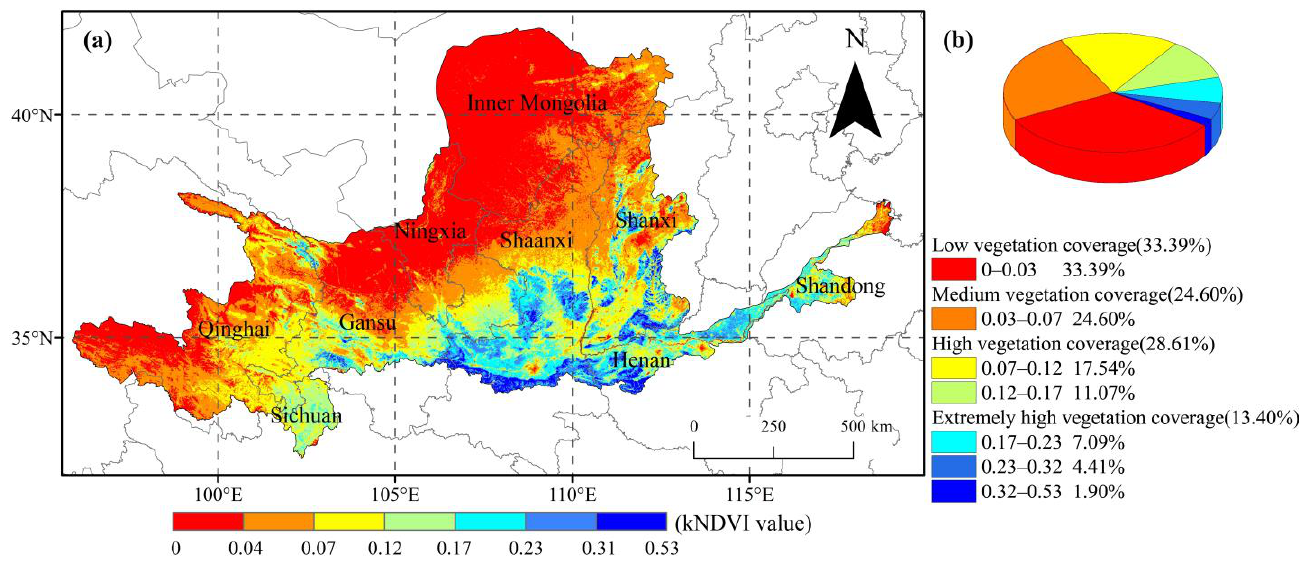
Figure 3. Spatial distribution of the vegetation coverage: ( a ) spatial distribution of median kNDVI from 2001 to 2020 in the YRB and ( b ) the proportions of each classification.